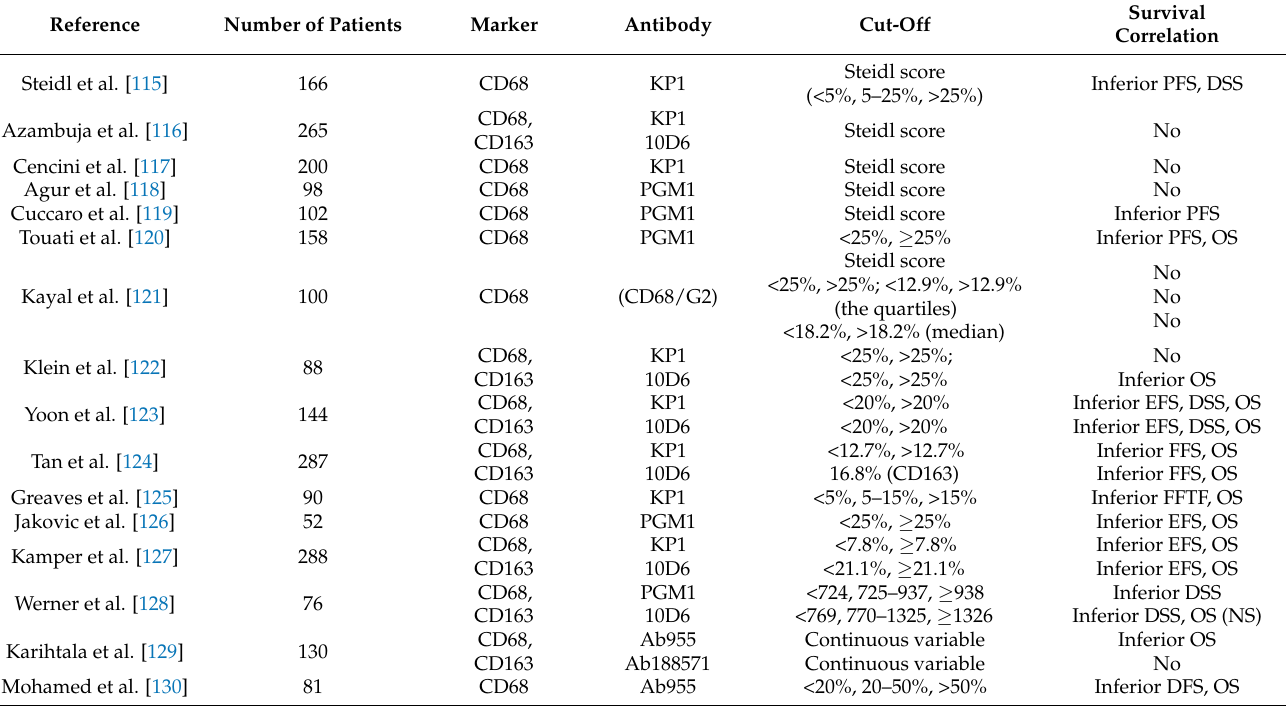
Table 1. Clinical studies about prognostic role of tumor-associated macrophages (TAM) in Hodgkin lymphoma.